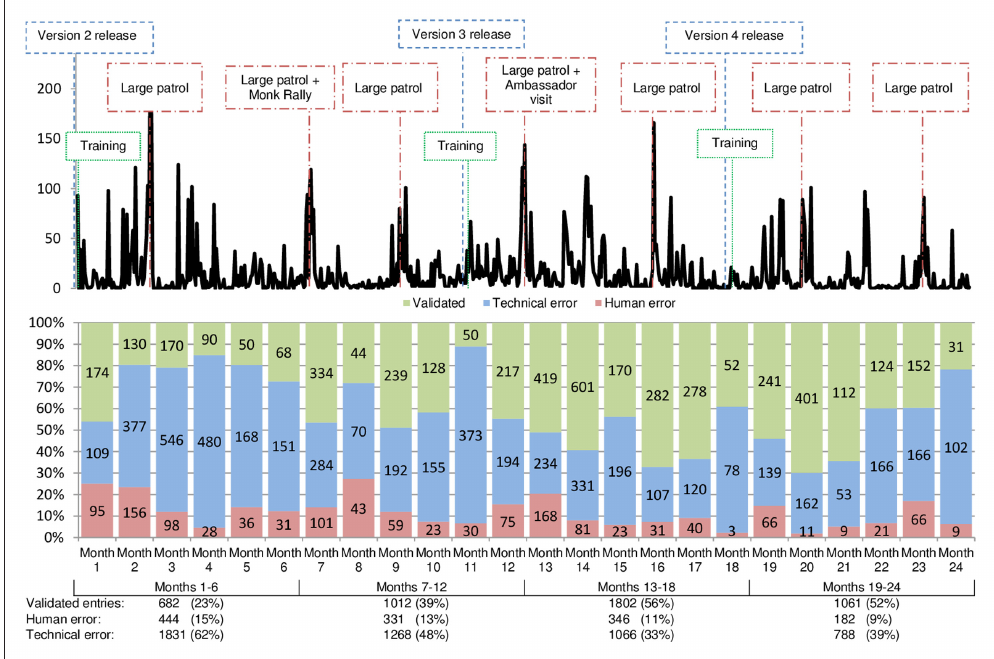
Figure 3: Data on forest crimes and forest resources collected by Prey Lang Community Network in Prey Lang, Cambodia, 2015–2017 (N = 10,842 entries). The black line (top) shows the total number of entries recorded per day within each month and the timing of app version releases (blue), large organized patrols (red), and training sessions (green). Bars show monthly percentages (%) of valid entries (green), entries excluded because of human error (blue), and entries excluded because of technical error (red), with the number of entries (n) within the three categories labeled on each bar. Table 3: Entries on forest crimes and forest resources in Prey Lang, Cambodia, recorded by age groups and gender (N = 36 persons). Shown are average number of total entries of data per patroller and average proportion of valid entries out of submitted entries per age group and gender in the community monitoring program February 2015 to January